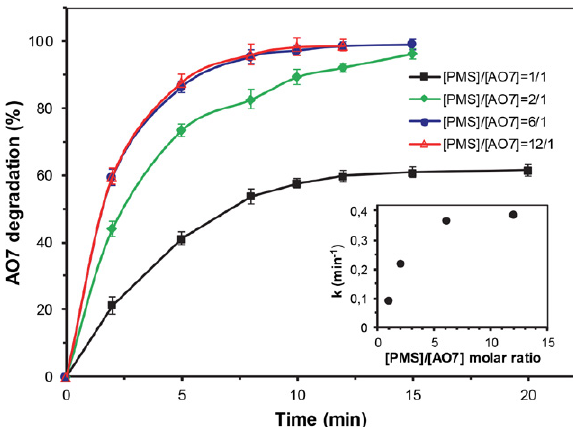
Fig. 12. Effect of PMS dosages on AO7 degradation and AO7 deg- radation kinetics (inset) by 50% Bi 2 O 3 -Co 3 O 4 /PMS oxidation sys- tem. Reaction conditions: 50 mg/L; [Catalyst] = 0.1 g/L; initial pH = 3.04; T = 293